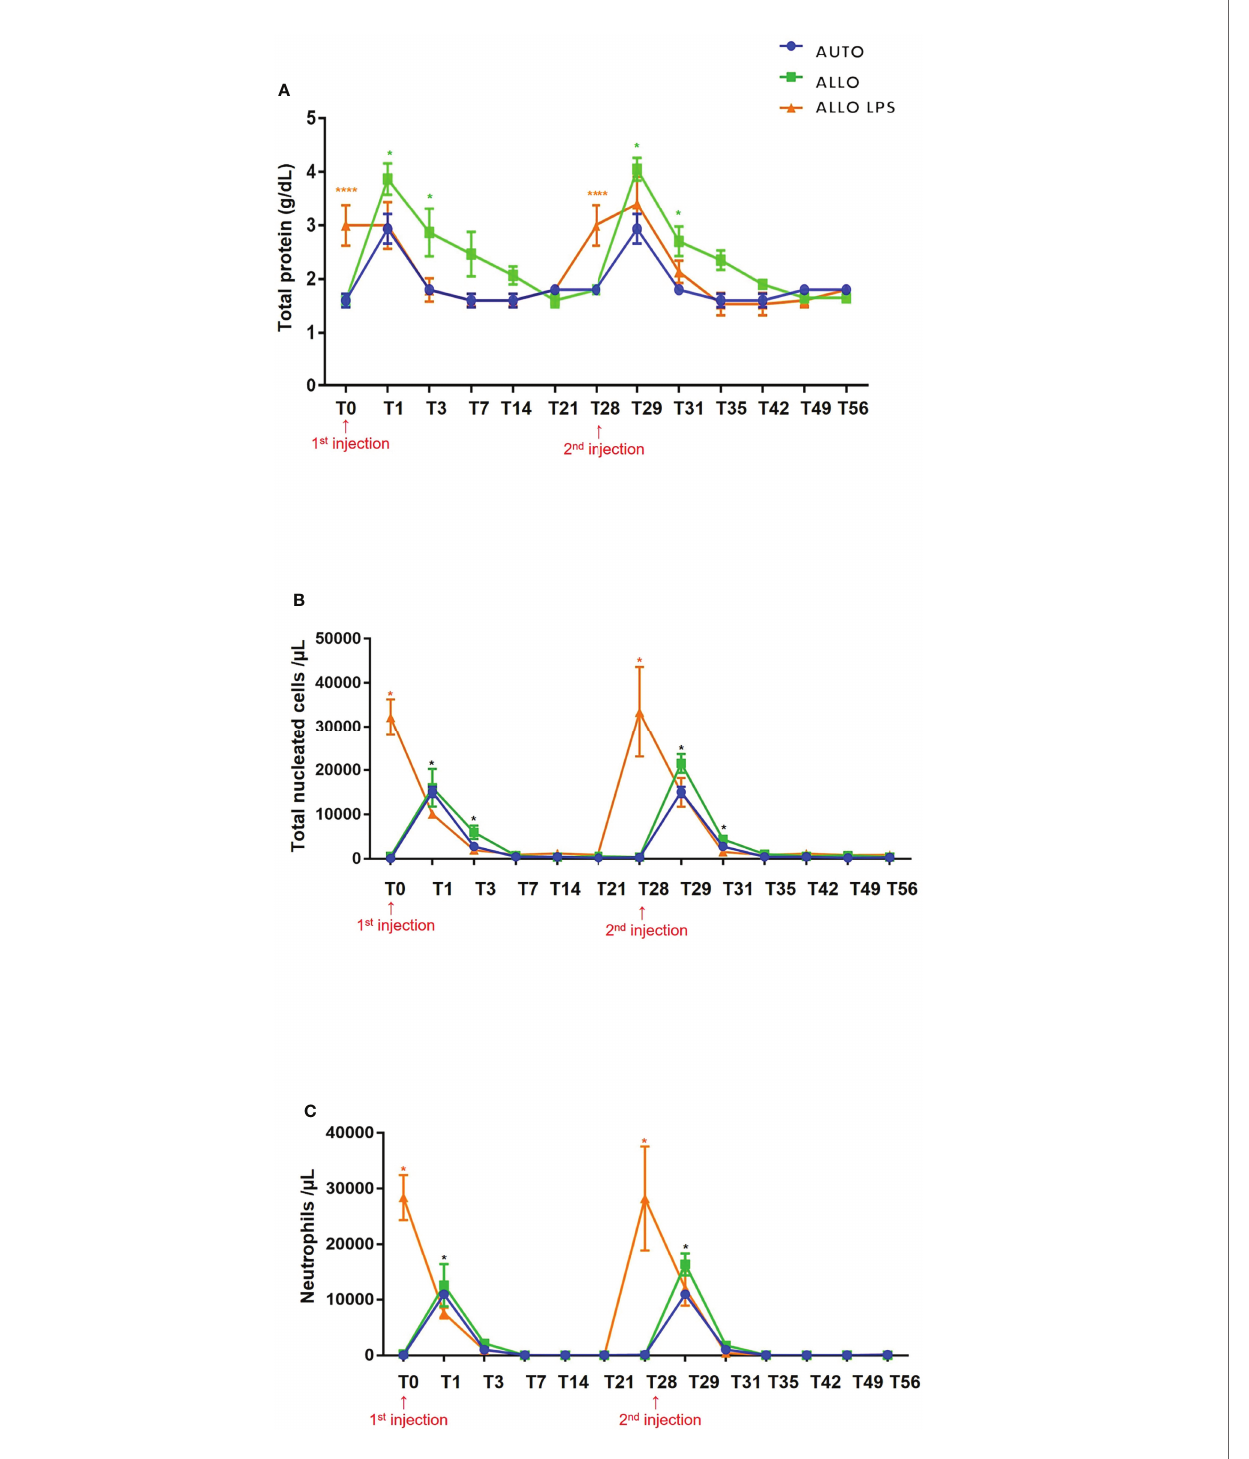
FIGURE 7 | (A) Mean ± SD values of synovial fl uid total protein (TP). Higher TP values were observed in ALLO LPS group at T0 and T28 (****P<0.0001). Statistical differences were observed between ALLO and AUTO groups at T1, T3, T29 and T31 (*P<0.05). (B) Mean ± SD values of synovial fl uid total nucleated cell count (TNCC), showing absence of statistical differences between groups in fi rst and second injections. Higher TNCC was observed in ALLO LPS group at T0 and T28 (*). Compared to the initial time point (T0 or T28), there was a signi fi cant increase in TNCC of all groups 1 and 3 days after SM MSC injection (T1 and T3; T29 and T31, respectively) (*P<0.05). (C) Mean ± SD values of synovial fl uid neutrophil count, showing a higher neutrophil count in ALLO LPS group at T0 and T28 (*P<0.05), whereas in ALLO and AUTO the peak occurred at T1 and